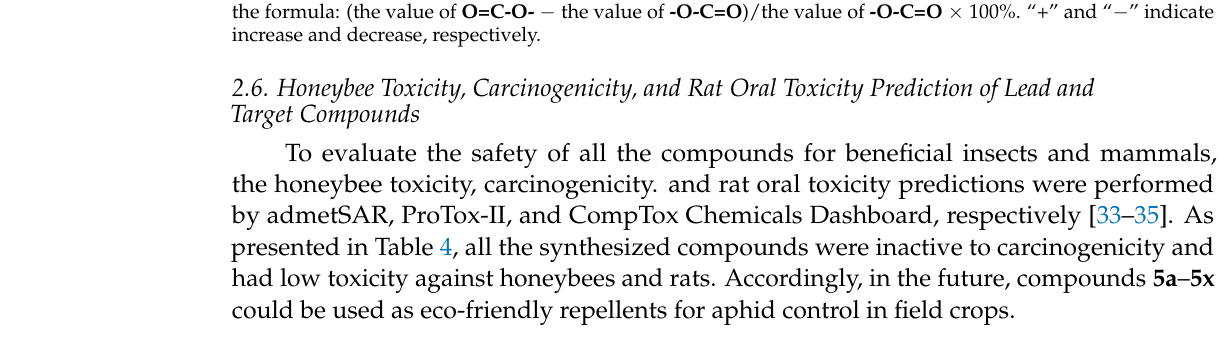
Table 4. Honeybee toxicity, carcinogenicity, and rat oral toxicity prediction of lead compounds and the synthesized